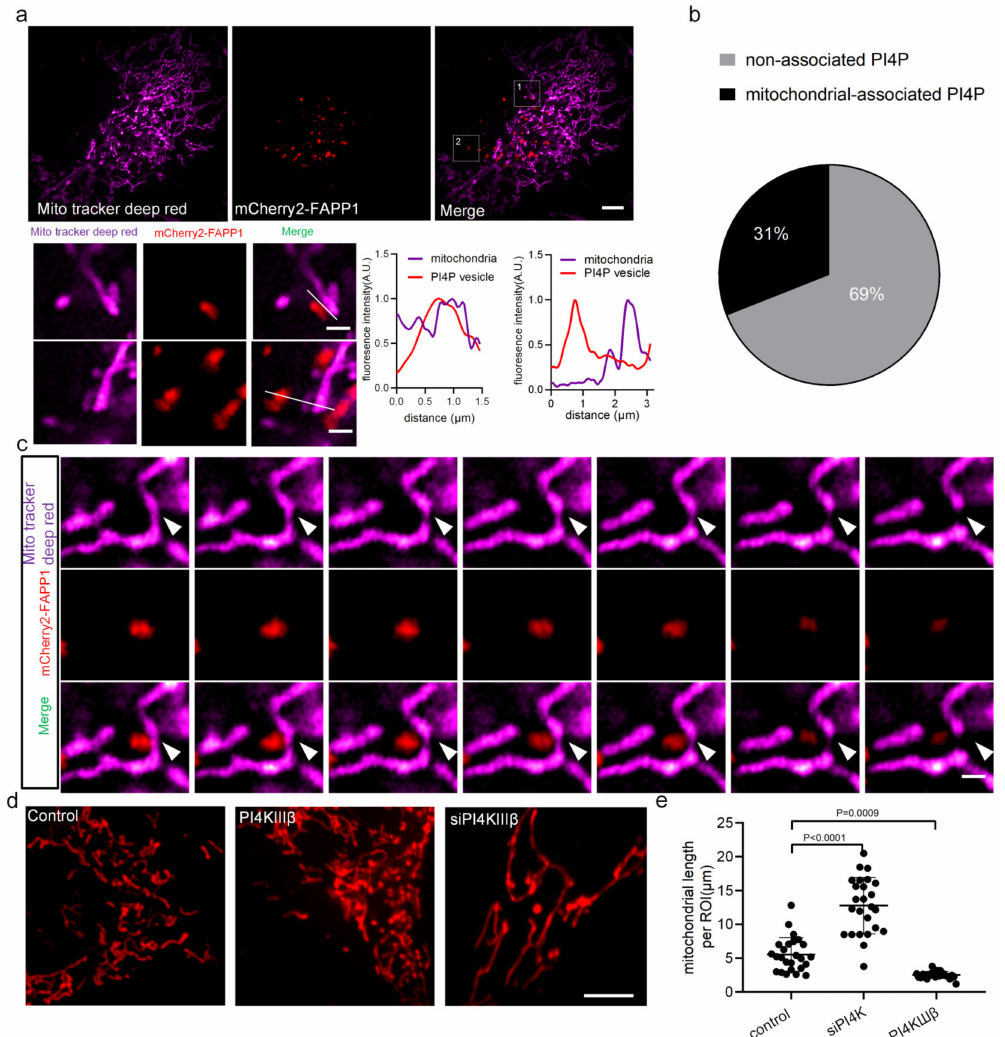
Figure 1. PI4P-containing vesicles regulate mitochondrial division. ( a ) SIM images of PI4P-containing vesicles (tagged with mCherry2-FAPP1, red) and mitochondria (stained with MitoTracker Deep Red, magenta) in U-2 OS live-cells. Two areas from a were shown at enlarged sizes with a line scan of the dotted line on the right Scale bar: 5 µ m, and 1 µ m. ( b ) Pie charts showing mitochondrion- associated versus -unassociated PI4P vesicles puncta. Our criterion for association with mitochondria was that PI4P-containing vesicles persist on mitochondria for at least 10 s. The percentage was calculated by determining the percentage of mitochondrial PI4P vesicles puncta at 3 min of imaging time in 300 PI4P-containing vesicles from 10 cells. ( c ) The images show a PI4P vesicle at the site of mitochondrial division. White arrows indicate the site of mitochondrial division. Scale bar: 2 µ m. ( d ) SIM images showing mitochondrial morphology (stained with MitoTracker Deep Red, red) in U-2 OS cells treated with the indicated small interfering RNAs (siRNAs), Scale bar: 5 µ m. ( e ) The quantification of mitochondrial length to determine the mean mitochondria length per region of interest (ROI) (225 µ m 2 ) in 20 cells. Cells from three independent experiments. All graphs show the mean ± SEM. Statistical significance: p < 0.001; p <